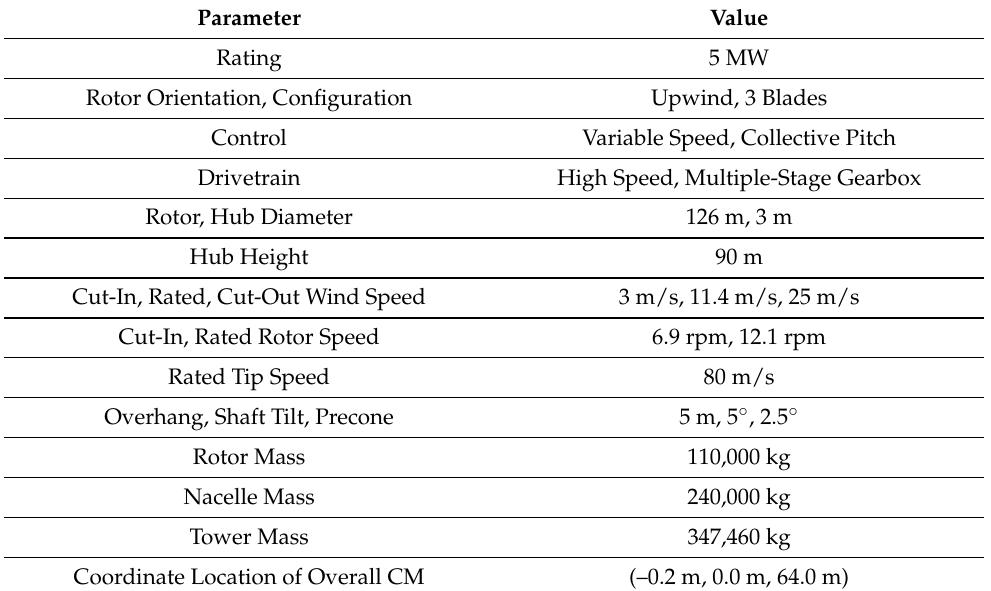
Table 1. Wind Turbine Parameters. Adapted from